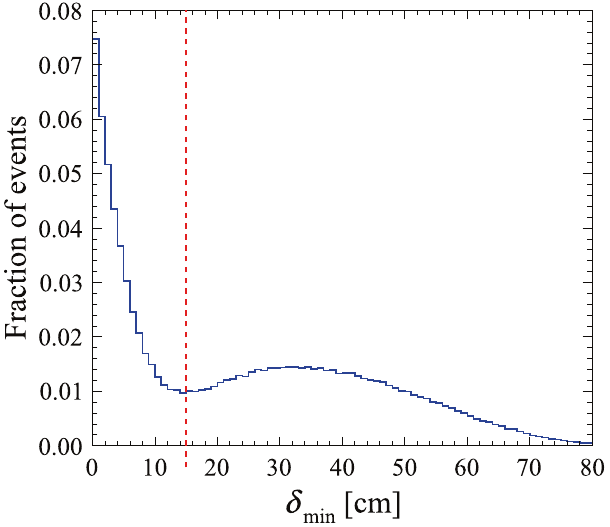
Fig. 4 Rejection of secondary Compton scatterings. Distribution of the minimal discrepancy between the travelled path and time of fl ight among all hypothetical secondary scattered photons considered in a single 3 γ event candidate. Events with δ min < 15 cm (marked with the red line) are discarded as containing secondary Compton scatterings in the detector